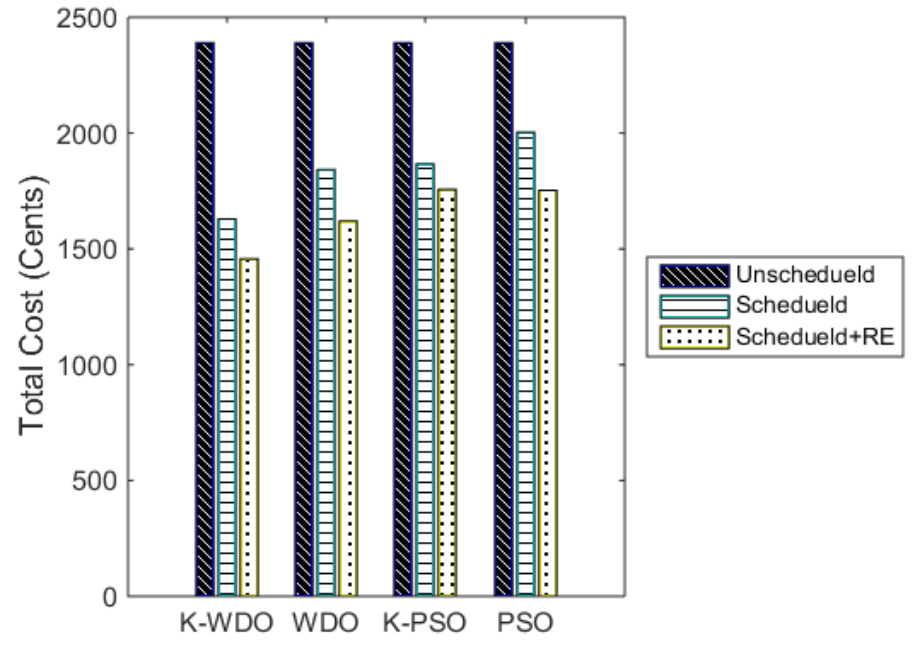
Figure 13. Electricity cost comparison of the WDO and PSO